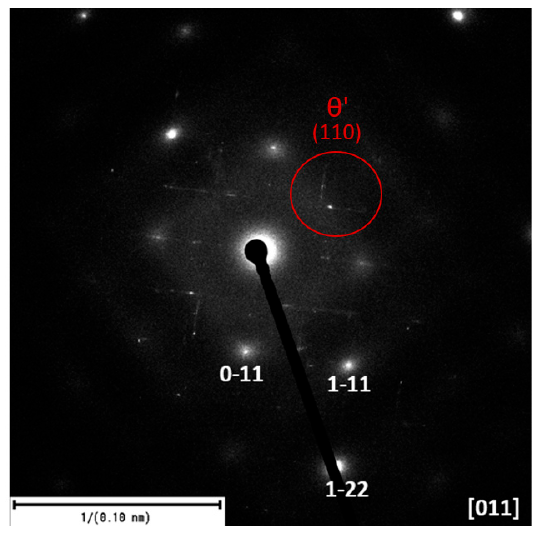
Figure 13. SAED of θ ’-Al 2 Cu phases of 20–80 alloy after artificial aging.